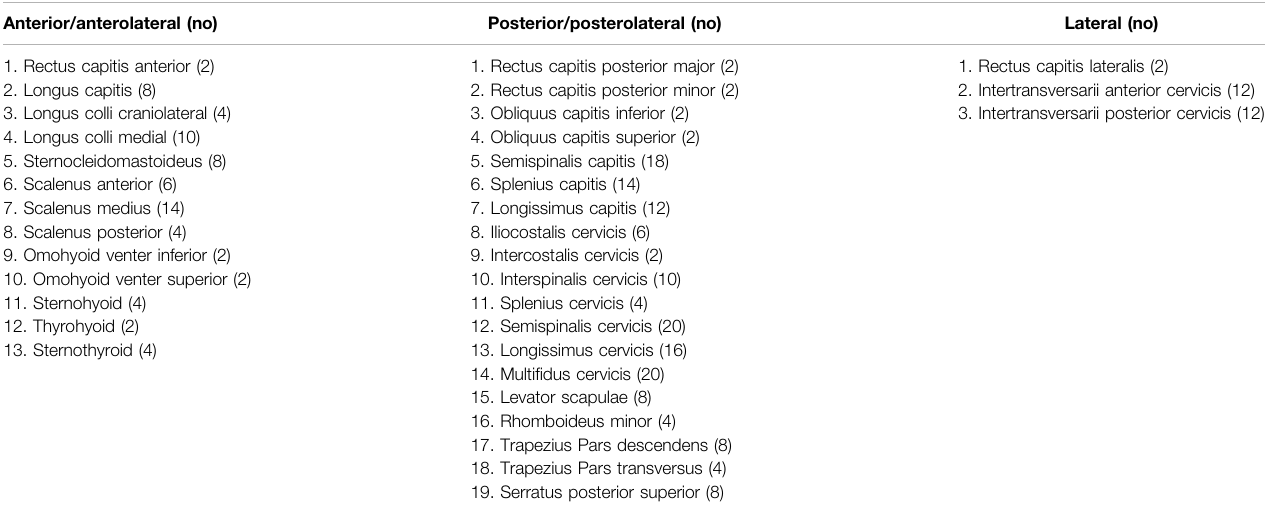
TABLE 2 | Head and neck muscle groups and the number of fascicles (sum of left and right) included in the musculoskeletal model. Anterior/anterolateral